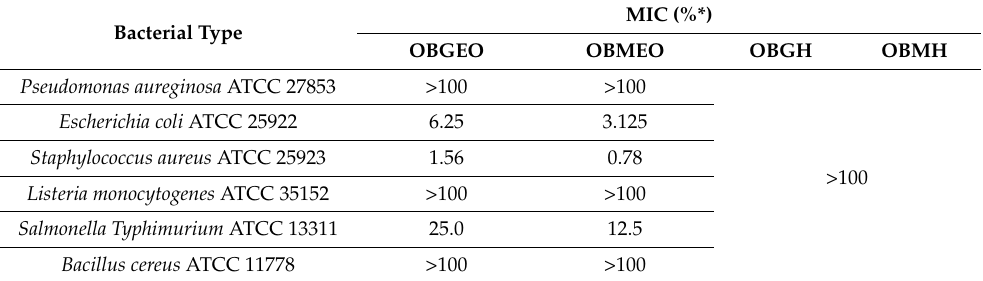
Table 4. Minimal inhibitory concentration (MIC) of O. basilicum essential oils and hydrolates. Bacterial